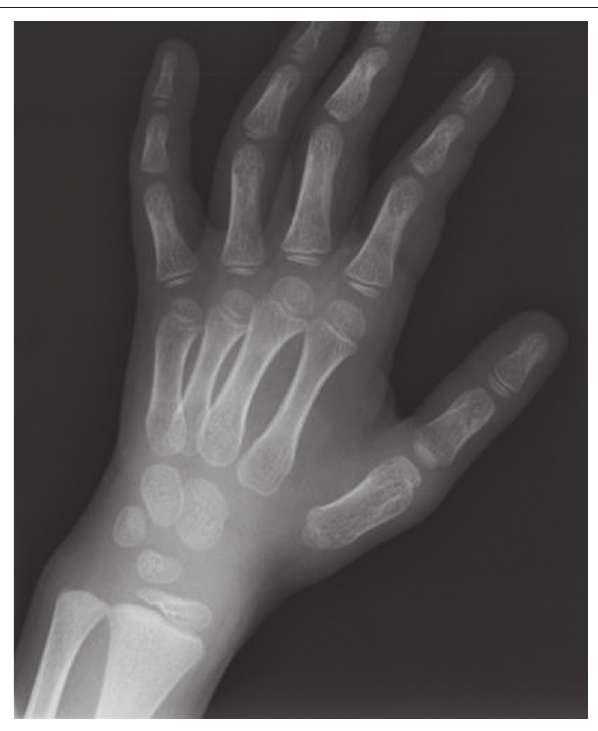
FIGURE 1: Conventional radiography demonstrates mild soft-tissue swelling over the volar aspect of the wrist with no underlying bony abnormality.